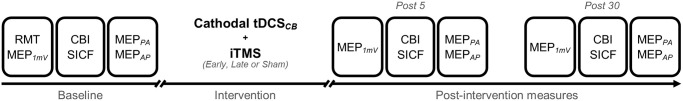
Experimental protocol.RMT, resting motor threshold; MEP1mV, standard MEP of ~ 1 mV at baseline; CBI, cerebellar-brain inhibition; SICF, short-interval intracortical facilitation; MEPPA, standard MEP of ~ 0.5 mV at baseline with PA orientation; MEPAP, standard MEP of ~ 0.5 mV at baseline with AP orientation; tDCSCB, transcranial direct current stimulation applied to the cerebellum; iTMS, I-wave periodicity repetitive transcranial magnetic stimulation.